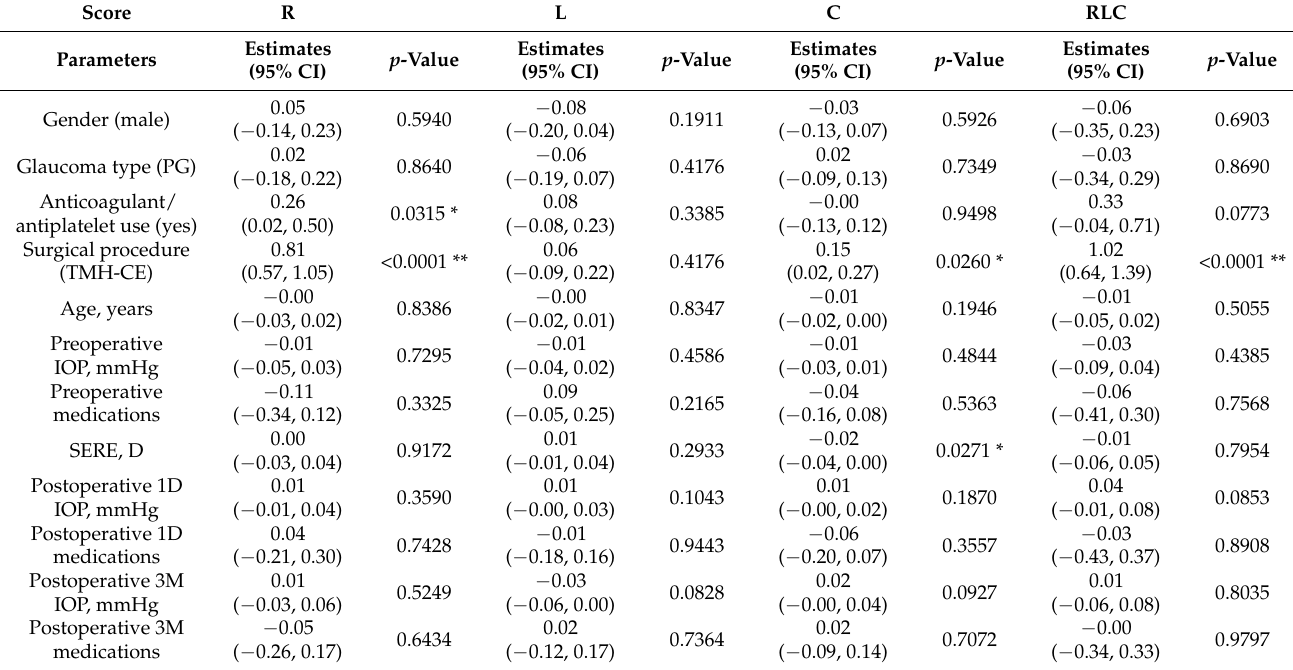
Table 6. Possible associations between postoperative day-1 RLC scores and various parameters analyzed by a multiple regression